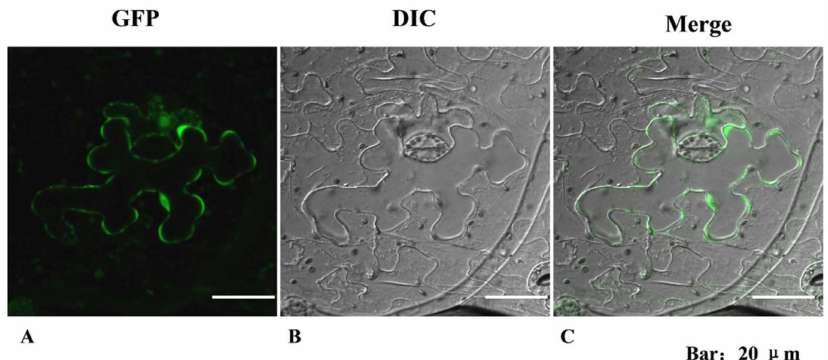
Figure 6. Localization of SlCOMT1. ( A ) Green fluorescence of SlCOMT1-PRI. ( B ) Bright-field image of Agrobacterium -infiltrated tobacco leaf. ( C ) The merged fluorescent images. The tobacco leaves were injected with the transgenic Agrobacterium liquid, and then cultivated in the culture chamber for 2 days and observed by confocal microscopy. GFP, Green Fluorescence Protein; DIC, Diascoptic Lighting